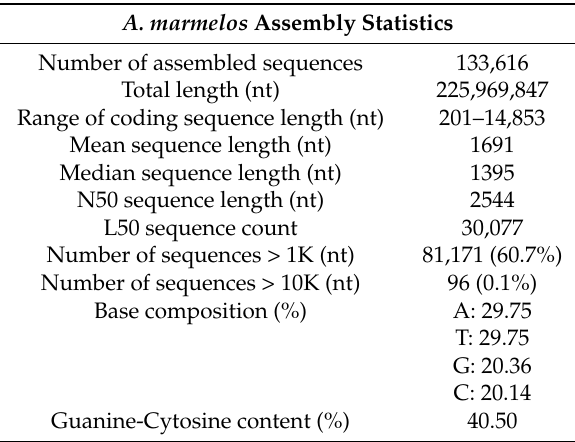
Table 1. Assembly statistics of the leaf transcriptome.